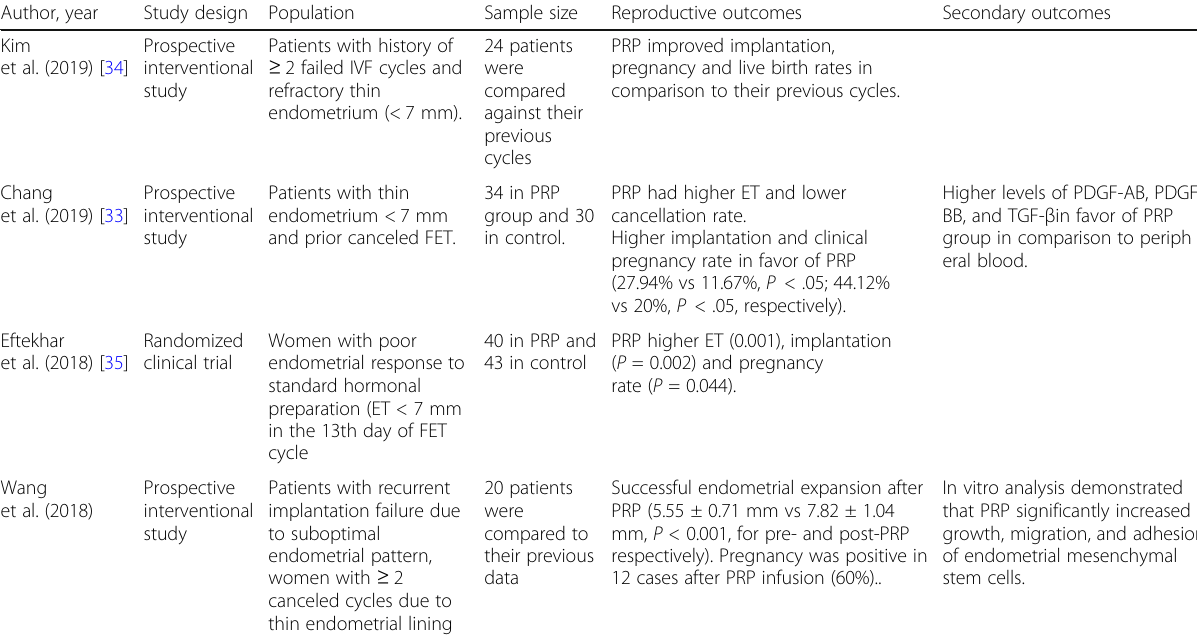
Table 1 Autologous platelet-rich plasma (PRP) infusion in cases of thin endometrium